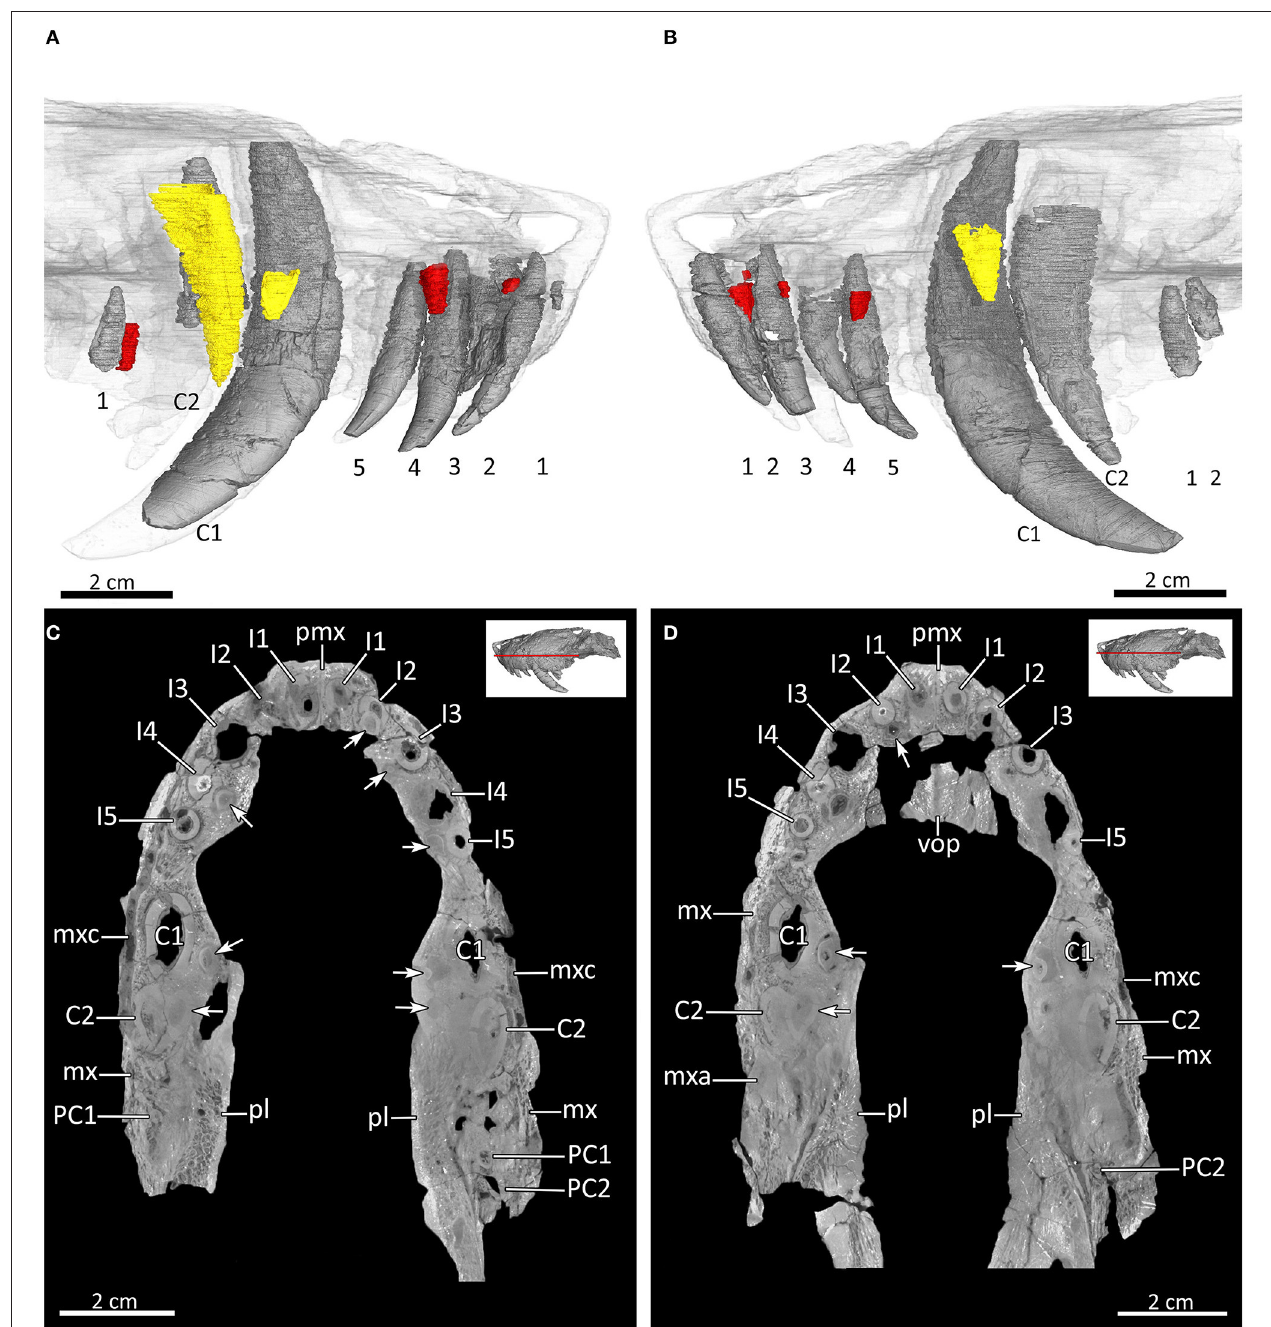
FIGURE 13 | Dentition and tooth replacement in the upper jaw of MB.R.995. (A) Three-dimensional rendering of the left and (B) right upper tooth rows in medial view. (C,D) Virtual horizontal CT sections through the upper jaw. Replacement canines in yellow; replacement incisors and postcanines in red. Arabic numerals indicate the teeth positions. Arrows mark the positions of the replacement teeth. C1, first canine; C2, second canine; I, upper incisor; mx, maxilla; mxa, maxillary antrum; mxc, maxillary canal; PC, upper postcanine; pl, palatine; pmx, premaxilla; vop, vomerine process of the premaxilla.